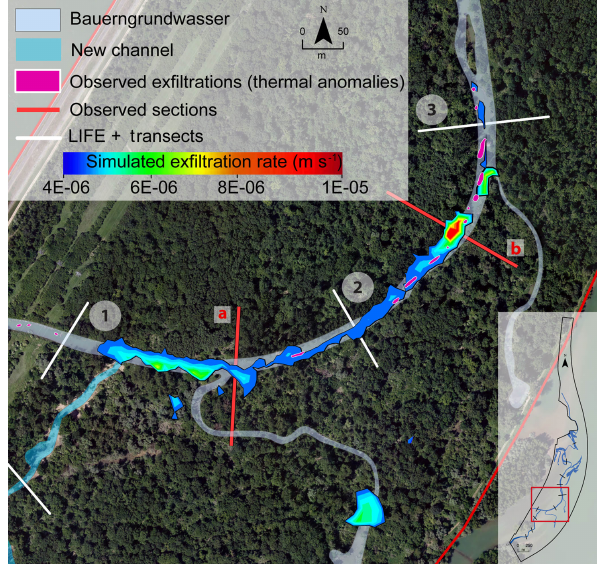
Figure 7. Comparison between simulated exfiltration patterns and thermal anomalies identified via thermal infrared imaging close to the junction between the new channel (southeast corner) and the BGW (Bauerngrundwasser; center of figure). Red transects a and b are locations where surface water and groundwater head are fol- lowed to exemplify surface–subsurface interactions in Fig.